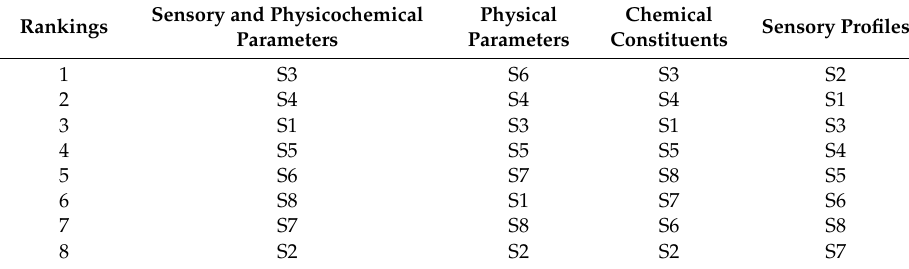
Table 5. The rankings according to di ff erent factors used in the technique for order preference by a similarity to ideal (TOPSIS) approach .